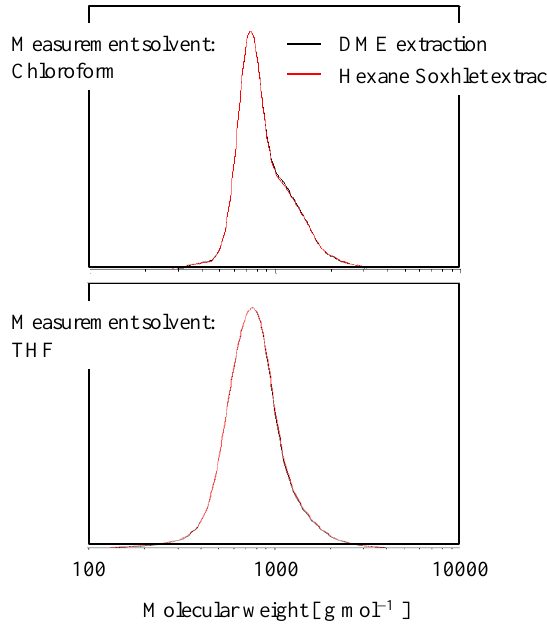
Figure 2. Molecular weight distributions of the